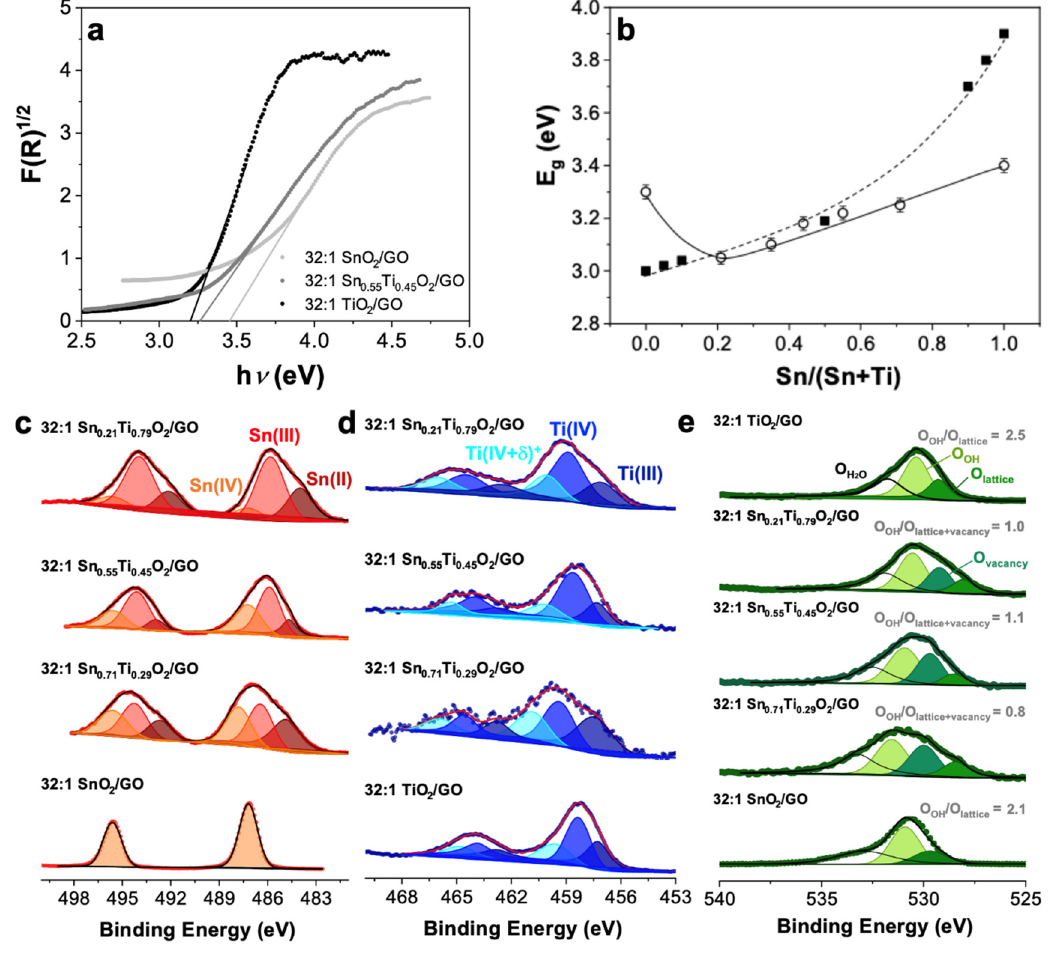
Figure 3. ( a ) Kubelka–Munk elaboration of the DRS spectra relative to 32:1 SnO 2 / GO, 32:1 Sn 0.55 Ti 0.45 O 2 / GO and 32:1 TiO 2 / GO. ( b ) Comparison between band gap (E g ) values obtained herein (circles) and the ones redrawn from literature (black squares) [39] as a function of the Sn / (Sn + Ti) ratio. XP spectra of ( c ) Sn 3d, ( d ) Ti 2p and ( e ) O 1s regions relative to three 32:1 Sn x Ti 1 − x O 2 / GO (with x = 0.71, 0.55 and 0.21) as representative samples. 32:1 SnO 2 / GO and TiO 2 / GO have been reported for comparison.